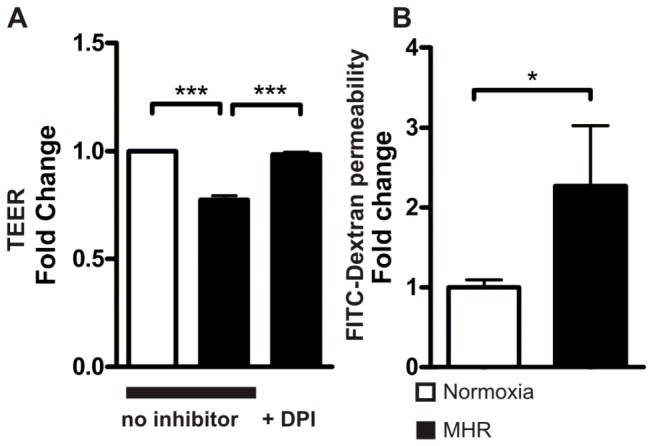
MHR impairs TEER in Brain endothelial cells and increases transcellular permeability towards high molecular mass molecules.Trans-endothelial resistance values detected with ECIS (A) were significantly lower in BEC after MHR than in normoxic conditions (normoxia 1 + 0.004 vs. MHR no inhibitor 0.77 + 0.02, P < 0.0001; n = 169 - 288 TEER measurements from 3 experiments). DPI prevented the decrease of TEER significantly (MHR+DPI 0.98 + 0.01 vs. MHR no inhibitor 0.77 + 0.02, P < 0.0001; n = 168 - 192 TEER measurements from 3 experiments). MHR resulted in an increase of FITC-Dextran (150,000 Dalton) permeability in bEnd.3 monolayers (normoxia 1 + 0.09 vs. MHR 2.27 + 0.75, P < 0.05; n = 7-15 permeability assays, B).